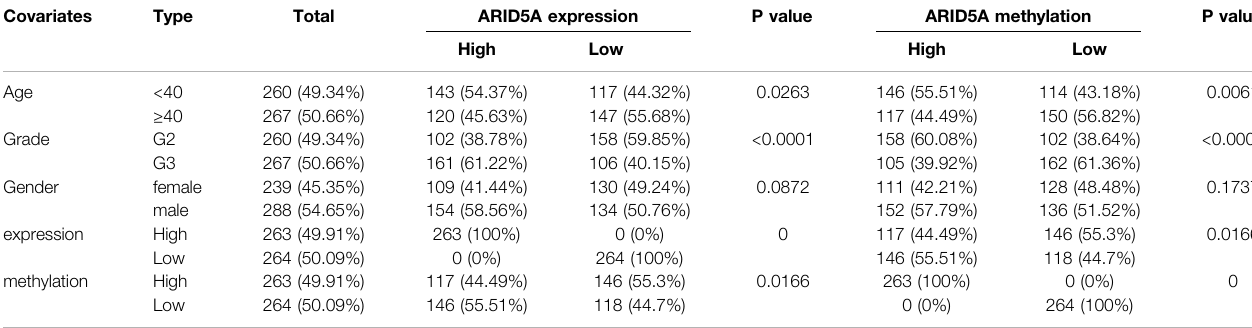
TABLE 1 | Correlation between TLR1 mRNA expression/methylation and clinicopathologic features in TCGA database.